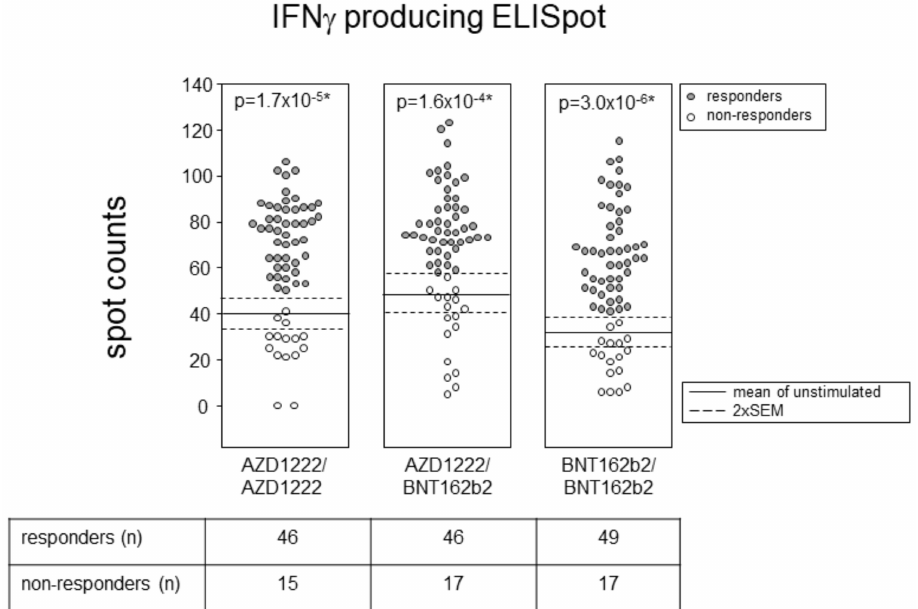
Figure 3. Homologous prime-boost with BNT162b2 yielded the highest T cell responses. Dot plots show absolute numbers of IFN γ -producing ELISpots resulting from 5 × 10 5 PBMCs stimulated with peptide pools representing the spike protein. Horizontal lines indicate means ± 2 SEM of IFN γ -producing ELISpots present in the absence of peptide stimulation. Each dot represents one individual and, in the case of more than mean + 2 SEM IFN γ -producing ELISpots, individuals were considered responders. p -values resulted from one-sample t -tests, comparing the numbers of ELISpots after peptide stimulation to the mean + 2 SEM numbers of ELISpots in the absence of stimulation. Pairwise comparisons via Wilcoxon matched pairs of unstimulated and stimulated numbers of ELISpots were 6.07 × 10 − 8 (AZD1222/AZD1222), 8.41 × 10 − 7 (BAZD1222/BNT162b2), and 4.49 × 10 − 9 (BNT162b2/BNT162b2). The table gives numbers of responders and non-responders resulting from each vaccination regimen. A chi-square test for independence confirms comparable proportions with a p -value of